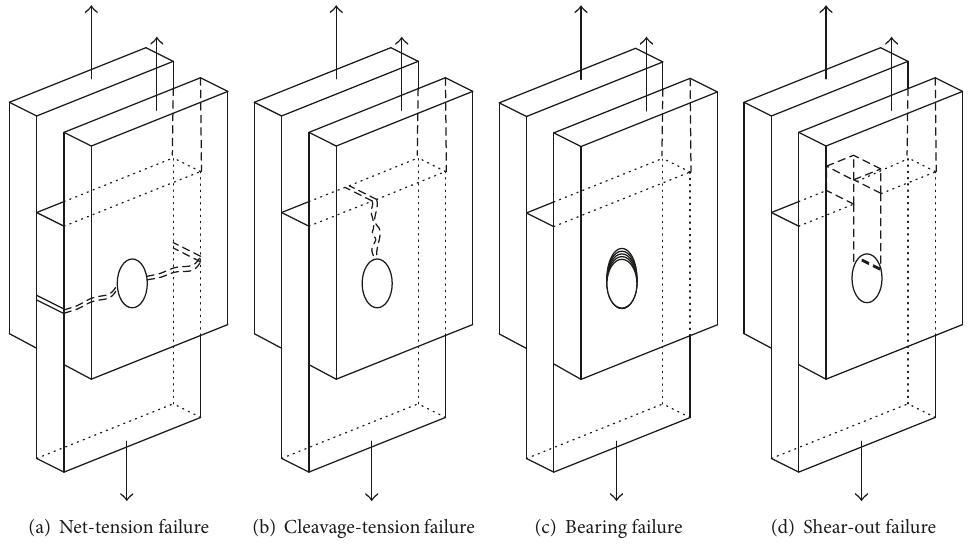
Figure 1: Typical failure modes of bolted